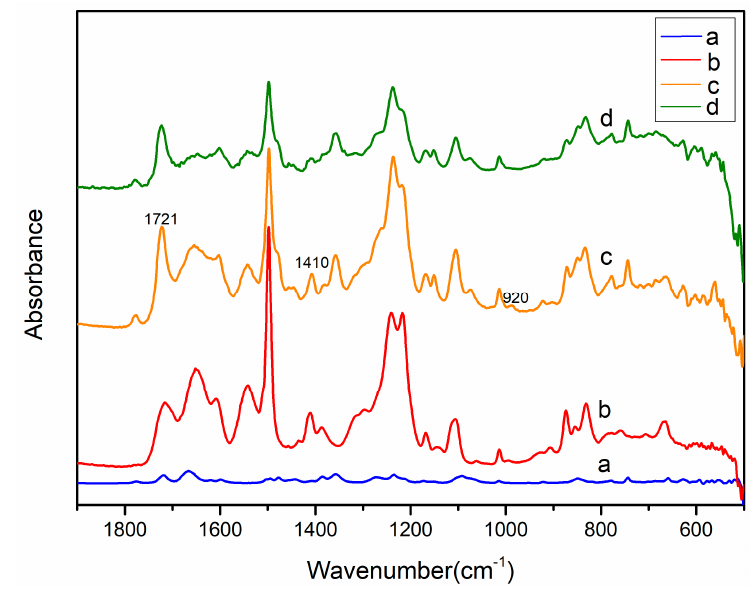
Figure 3. FTIR spectra of ( a ) pure PEI; ( b ) pure PMDA/ODA-based PAA; ( c ) PAA/PEI film; and ( d ) PAA/PEI film after silver ion exchange and DMAB reduction.